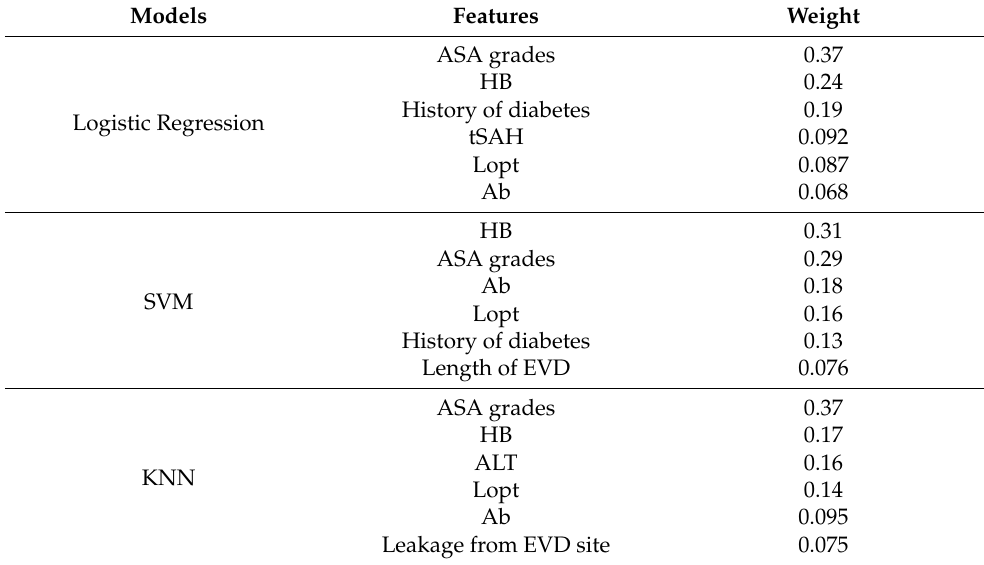
Figure 2. LASSO regression for feature selection. Different color lines represent different variables. LASSO regression used least absolute shrinkage and selection operator (LASSO). Se-